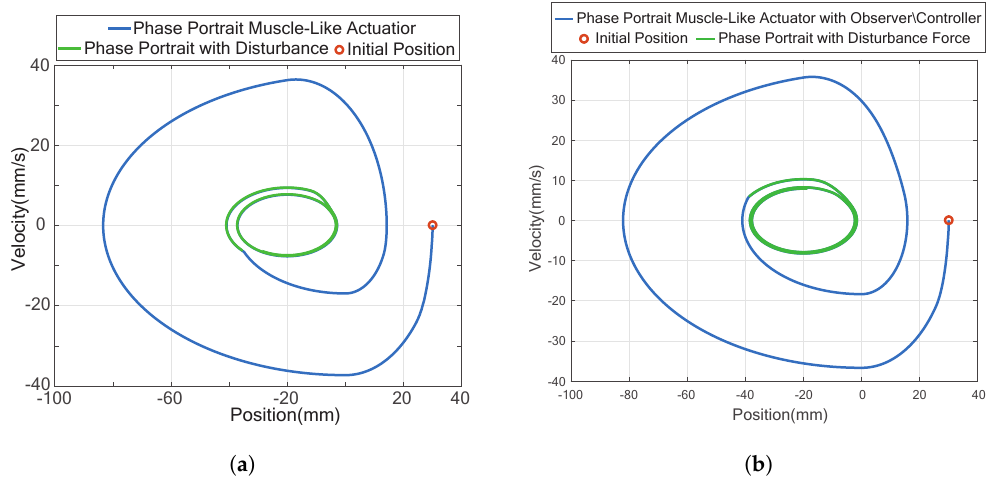
Figure 12. Introduction of a disturbance force into the system: ( a ) control Method I with disturbance (green); and ( b ) control Method II with disturbance (green).